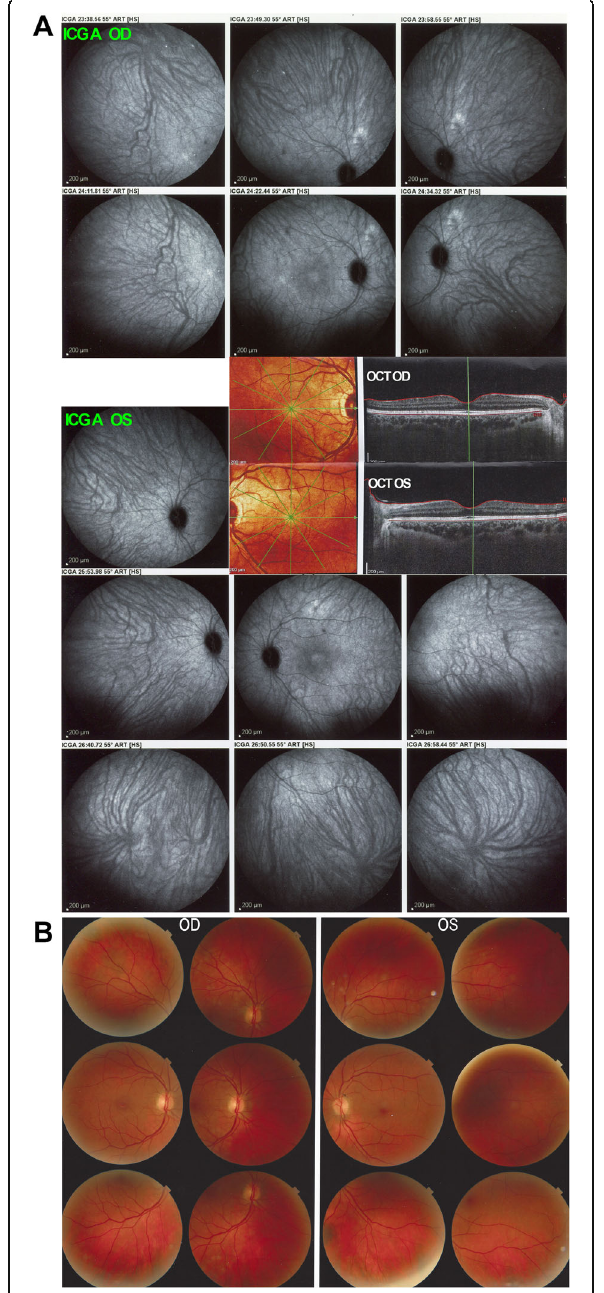
Fig. 4 a ICGA and OCT after 6 years of infliximab treatment. ICGA pictures show a normal choroid devoid of HDDs and normal OCT images ODS (insert). b Fundus photographs ODS seven years after initial-onset VKH disease. Absence of notable sunset glow fundus 2 months prior to post-vaccination recurrence